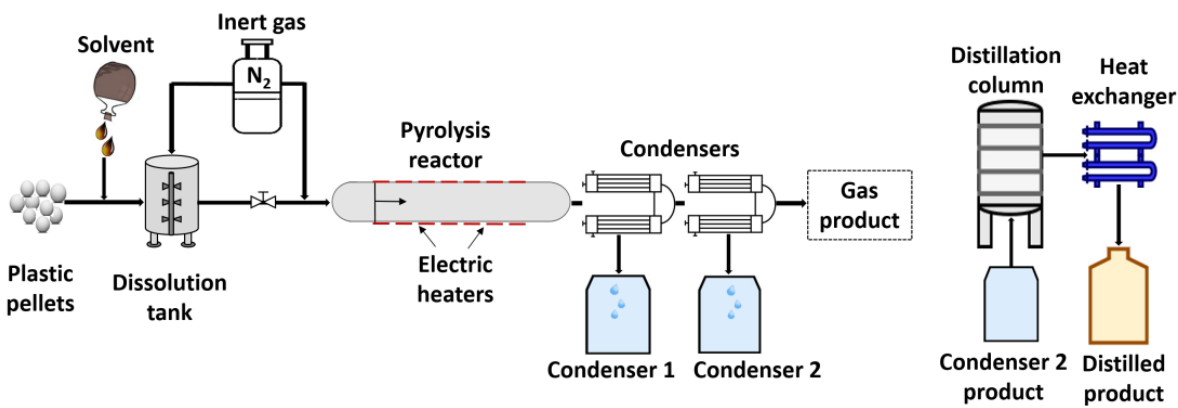
Figure 1. Schematic of plastic pyrolysis apparatus and batch distillation column.